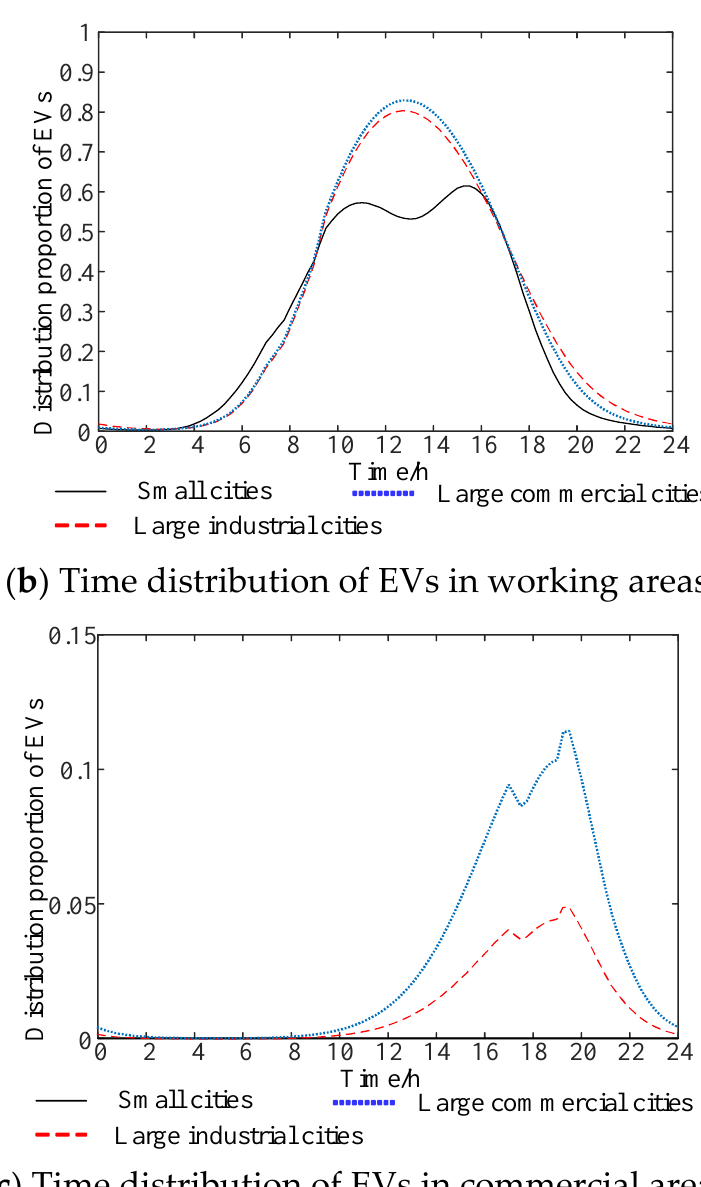
Figure 6. Time distribution of electric vehicles in different functional areas. Based on the idealized assumption that small cities have simple work chain A and complex work chain B, both of which do not have a work–entertainment trip, there is no work–entertainment chain in small cities. EVs are only distributed in working and residential areas. In addition, because some EV users in small cities return home for lunch, some EVs are transferred from working to residential areas during the lunch hour. In large cities, EV users make a trip for entertainment after work, so some electric vehicles are moved to the commercial area at night. Three distinct shifts can be observed as the proportion of H–W–E–H trips (i.e., the degree of commercialization) increases: (1) the proportion of EVs in residential areas from 12:00 to 22:00 decreases; (2) the proportion of EVs in commercial areas from 12:00 to 22:00 increases; and (3) more EVs in the working area are transferred to the commercial area from 17:00 to 22:00. There is also a small fluctuation among in the distribution probability curves for EVs in the three regions. This fluctuation exists because our model accounts for traffic encountered in the actual travel